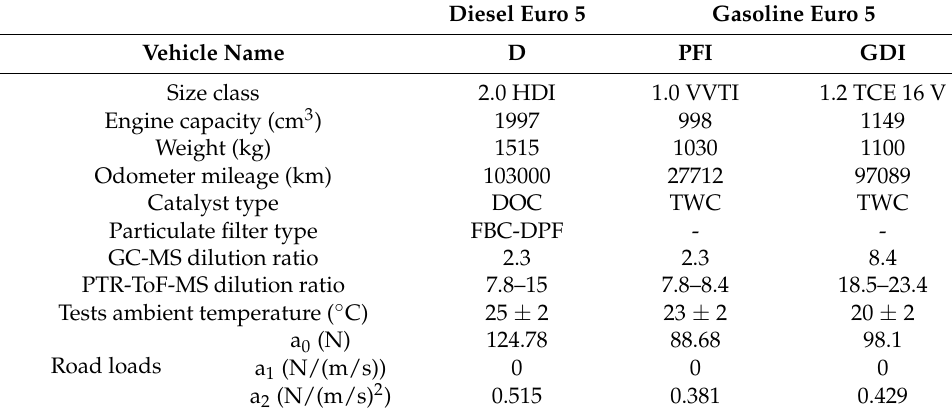
Table 1. Technical characteristics of the tested vehicles and experimental conditions.